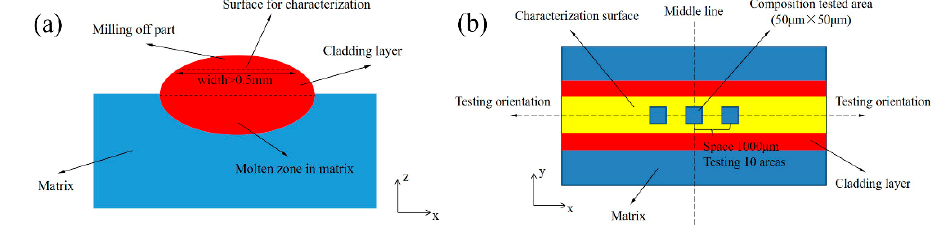
Figure 3. Schematic diagram of measurement of microstructure and composition of cladding layer. ( a ) sample preparation; ( b ) composition testing by area model.